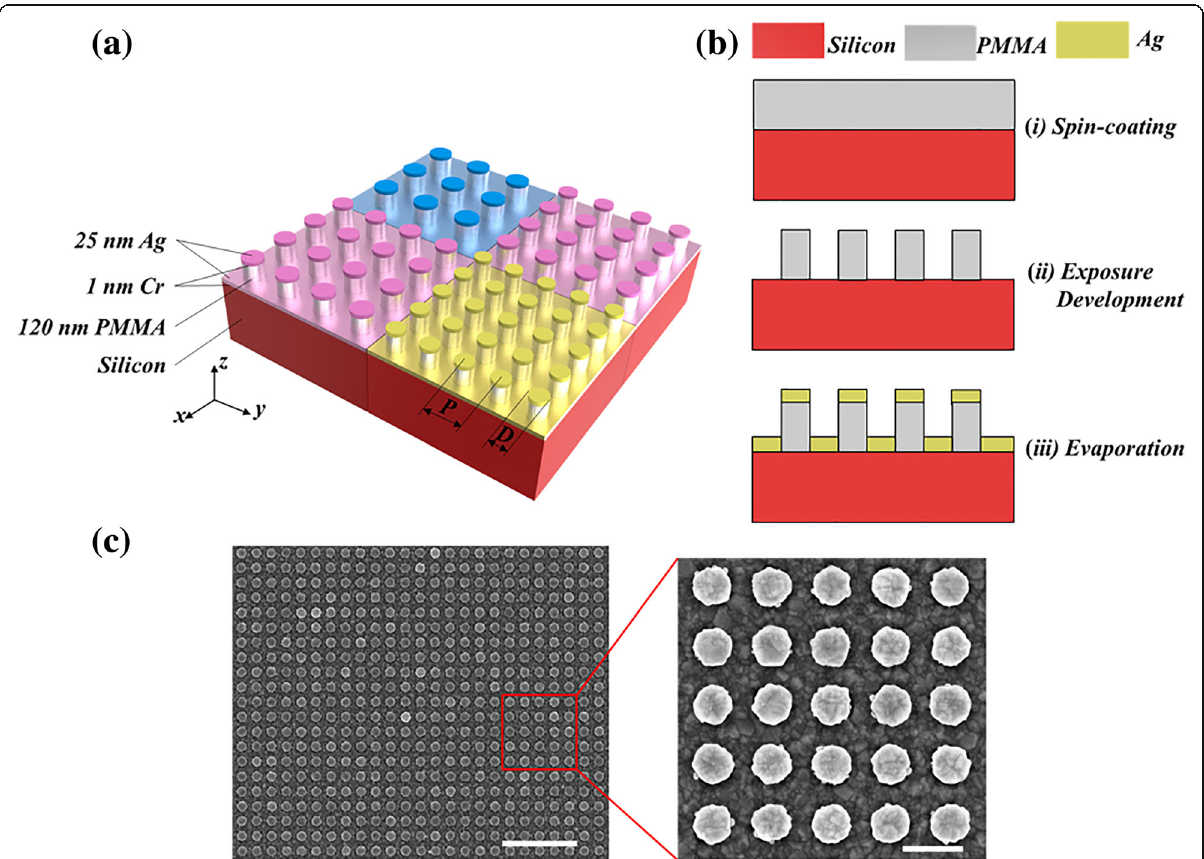
Fig. 1 a Illustration of the circular nanodisk-nanohole hybrid nanostructure arrays on silicon substrate. b The schematics of the fabrication process for the designed nanostructures. c SEM images of the fabricated nanostructure arrays with P = 200nm and D = 130nm. The inset gives an enlarged view. The scale bars are 1 μ m (left) and 200nm